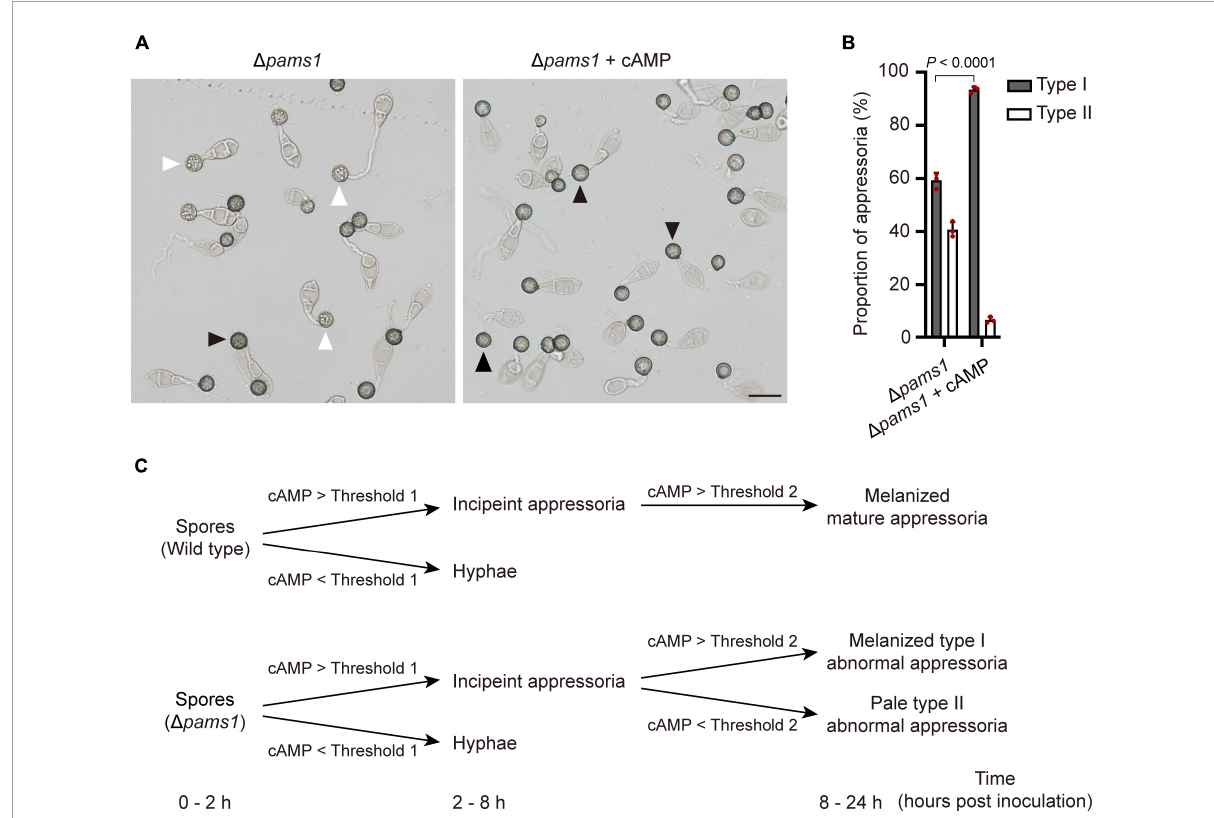
FIGURE12 Addition of exogenous cAMP increased the proportion of melanized type I abnormal appressoria formed by (cid:49) pams1 on plastic coverslips. (A) Appressoria formed by (cid:49) pams1 on plastic coverslips after treatment with 10 mM cAMP at 24 hpi. Black arrows indicate type I abnormal appressoria, and white arrows indicate type II abnormal appressoria. Scale bar, 20 µ m. (B) Proportions of types I and II abnormal appressoria formed by (cid:49) pams1 on plastic coverslips treated with 10 mM cAMP. The wild type did not form abnormal appressoria on plastic coverslips. At least 110 appressoria were counted per replicate. (C) Schematic illustration of how intracellular cAMP levels affect the differentiation of spores into incipient appressoria and then into mature appressoria in (cid:49) pams1 . On a membrane surface, if the intracellular cAMP content is higher than threshold 1, the germinated spore of (cid:49) pams1 differentiates into an incipient appressorium or it differentiates into a hypha; if the intracellular cAMP of the incipient appressorium is higher than threshold 2, the appressorium continues to develop into a melanized type I